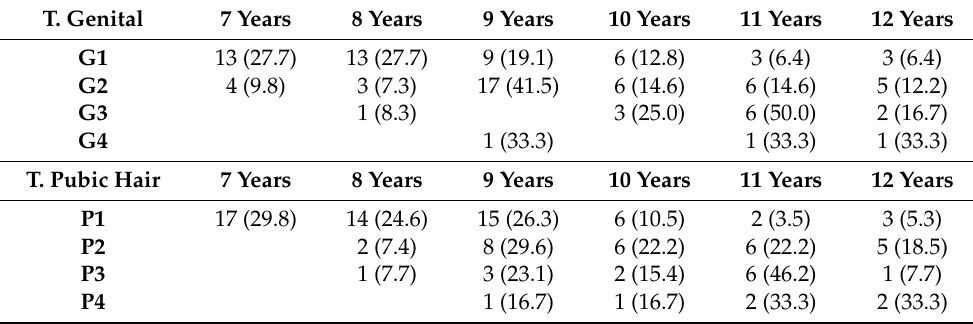
Table 2. Frequency (%) of boys according to Tanner’s sexual maturation stages and